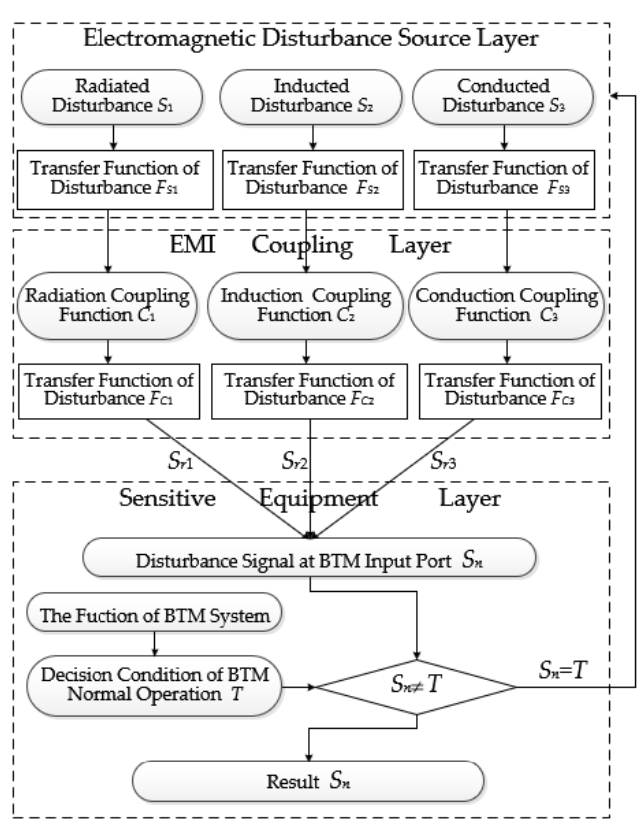
Figure 4. Prediction Process of Module System-level Model.